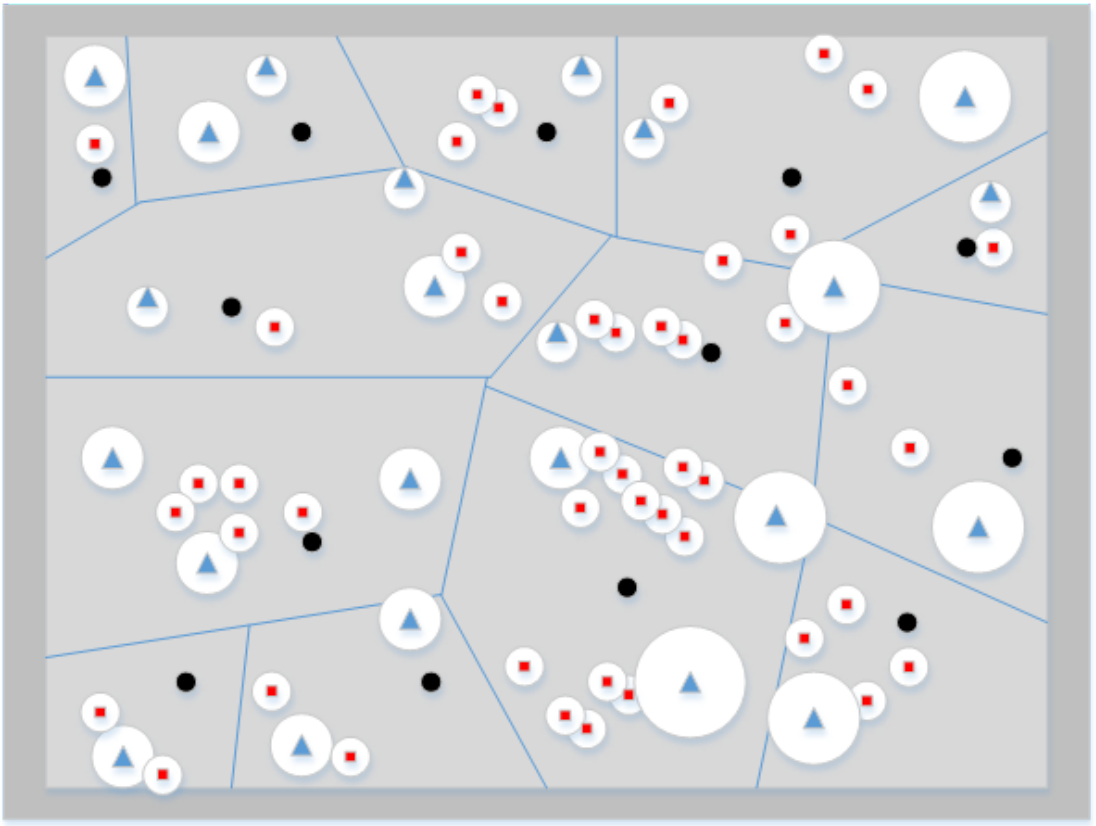
Figure 2. 3-tier HHWN max SINR downlink coverage regions with macrocells, picocells, and femtocells.